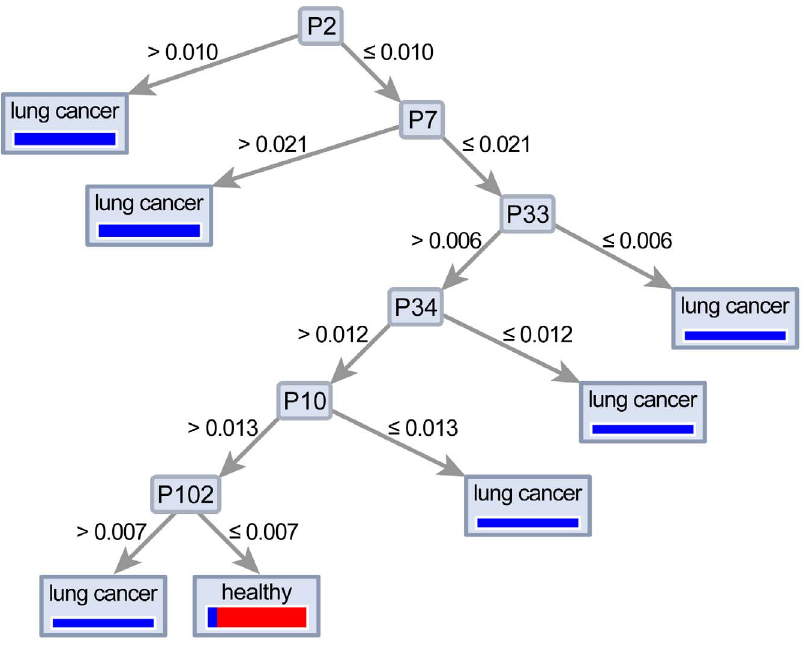
mutation displayed a significantly higher n-Dodecane VOC peak than for 14 lung adenocarcinoma patients negative for the EGFR mutation without 4 patients positive for ALK fusion (p , 0.01), with a sensitivity of 85.7% and a specificity of 78.6% (Figs. 4 and 5). Comparing VOC peaks between squamous cell carcinoma and the healthy group, 11 VOC peaks were found to have significance higher than 95% and peak- 69 was able to separate the best value with a sensitivity of 97.4 and a specificity of